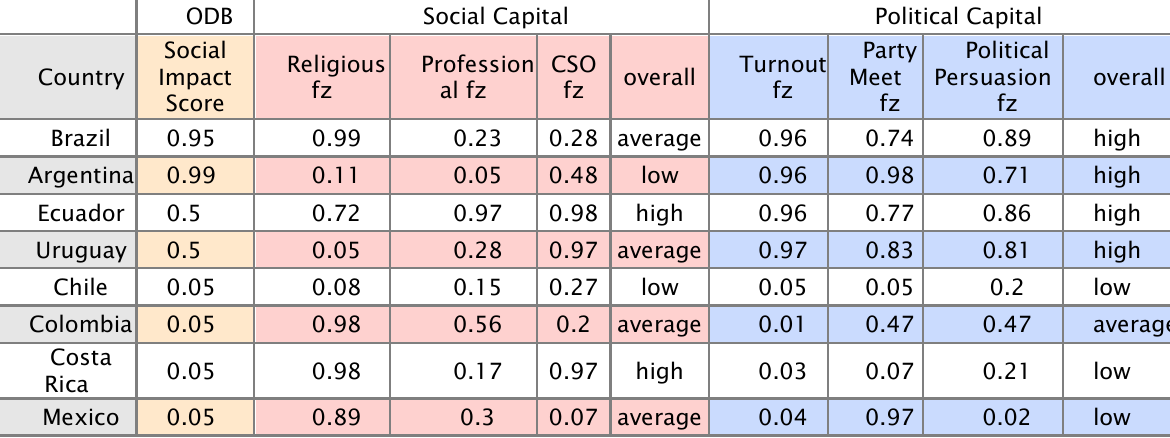
Table 3. Fuzzy Logic Calibrated Scores ODB Social Capital Political